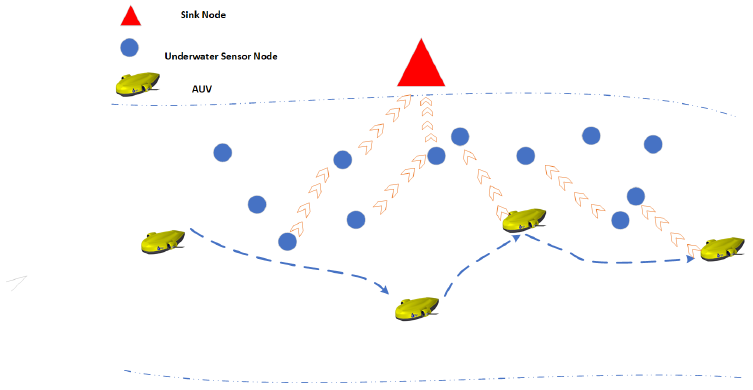
Figure 1. The schematic diagram of